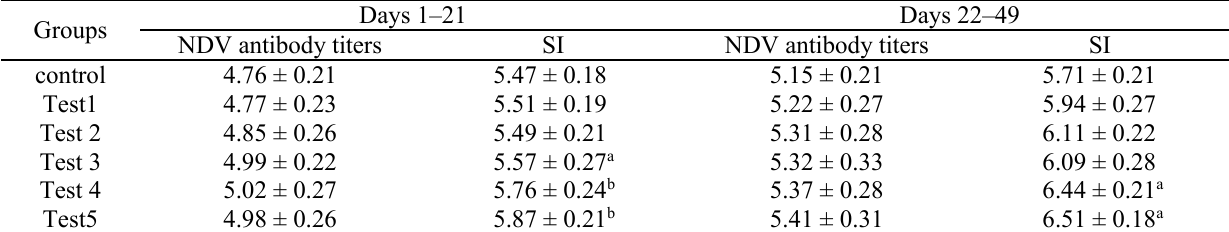
Effects of CB on NDV antibody titers and SI of broilers (n = 6) Groups